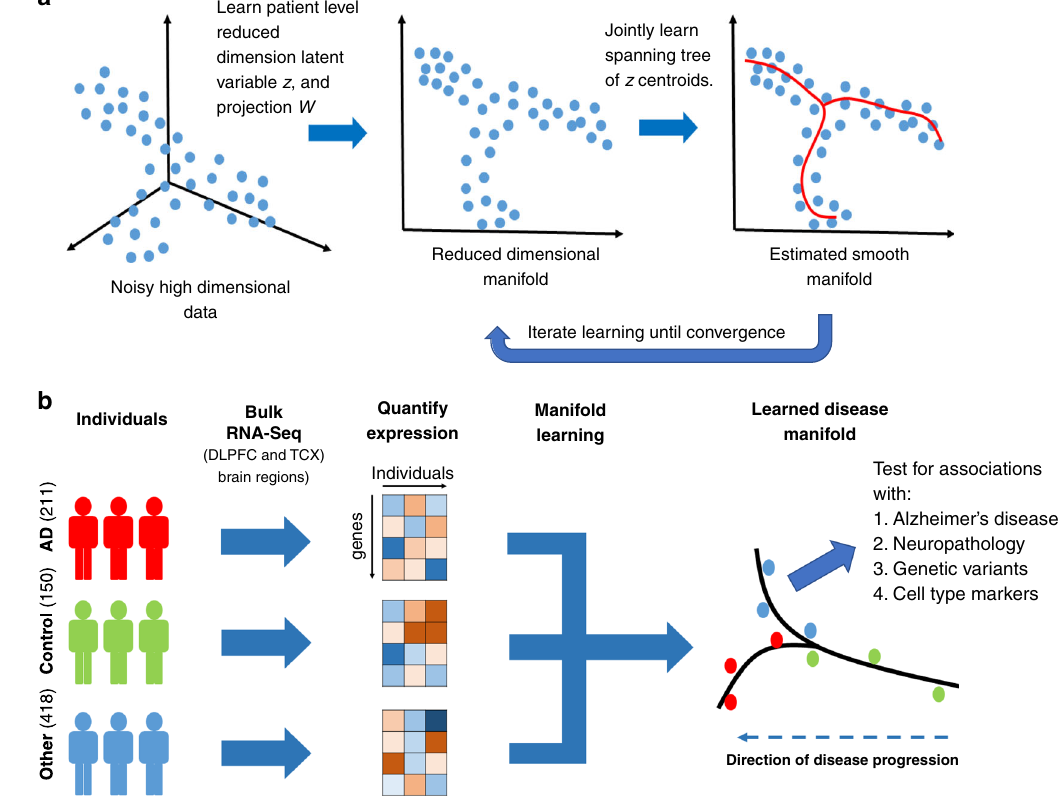
Fig. 1 Overview of manifold learning for unraveling staging in Alzheimer ’ s disease. a Illustration of steps in manifold learning using reverse graph embedding DDRTree method. b Illustration of lineage inference process for LOAD. RNA-seq samples with different disease diagnoses were pooled, batch normalized, and a smooth manifold was learned for each brain region across individuals (each point is an individual). Total sample numbers are indicated across Mayo RNA-seq TCX and ROS/MAP DLPFC for the different diagnoses in